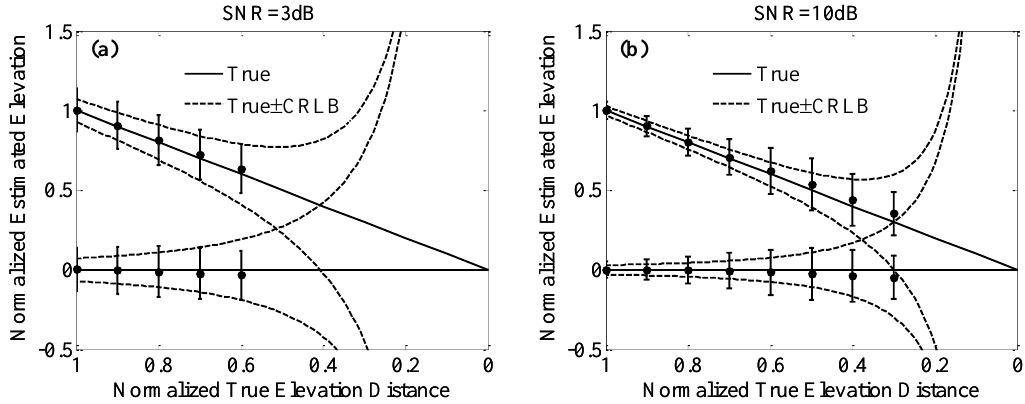
Figure 9. Elevation accuracy of the proposed CS-GLRT compared to CRLB: ( a ) SNR = 3 dB; and ( b ) SNR = 10 dB. The y value of each dot reflects the sample mean of the estimated elevations and the corresponding error bar shows the standard